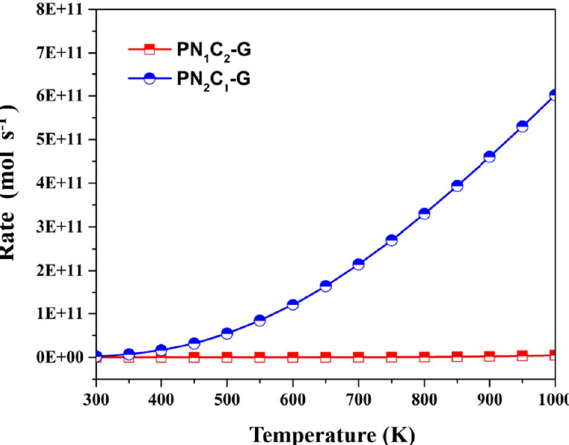
Figure 7. Rate of reaction for ER mechanism on PN 1 C 2 -G and PN 2 C 1 -G surface as function of temperature.